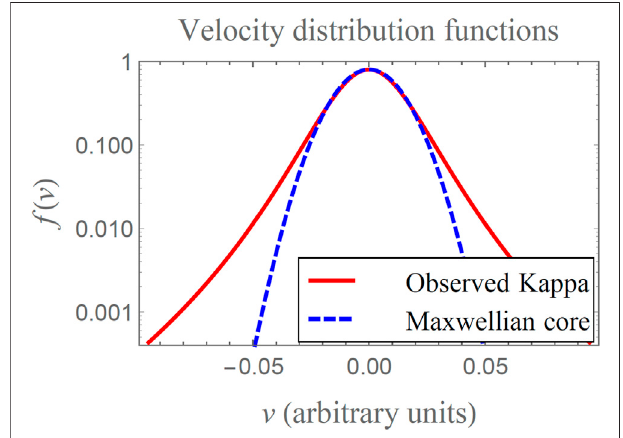
FIGURE 1 | 1D representation contrasting the observed (global) Kappa distribution with enhanced high-energy tails (red line) with the Maxwellian low- energy core (dashed blue line) in the absence of suprathermal